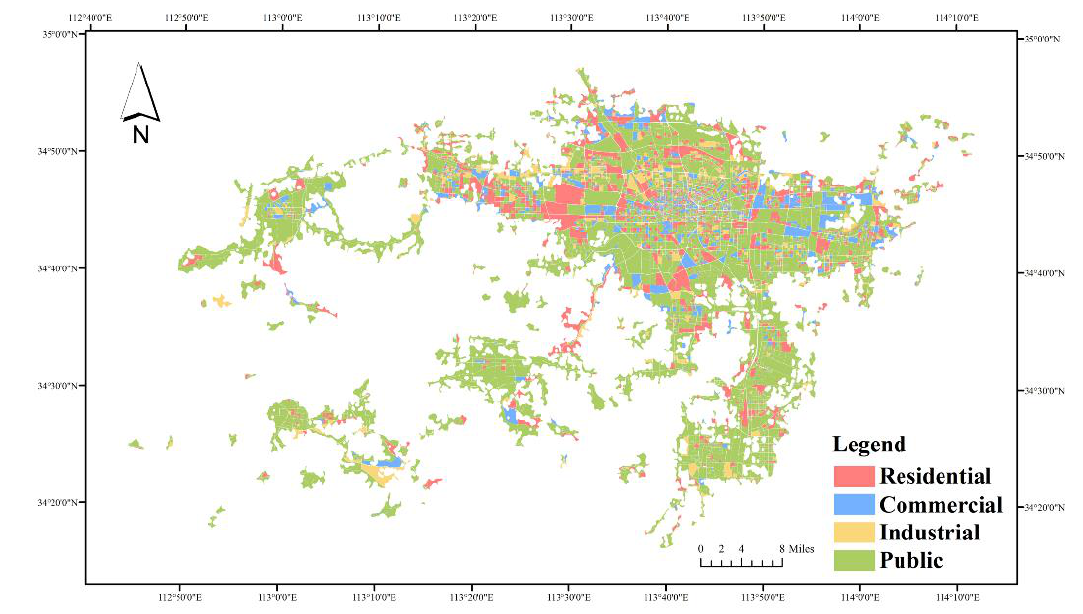
Figure 8. Classification map of Level I features in Zhengzhou.